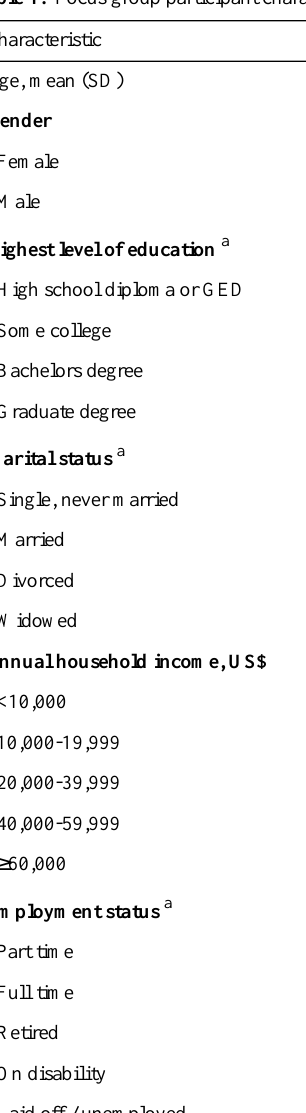
Table 1. Focus group participant characteristics (n=16, except where